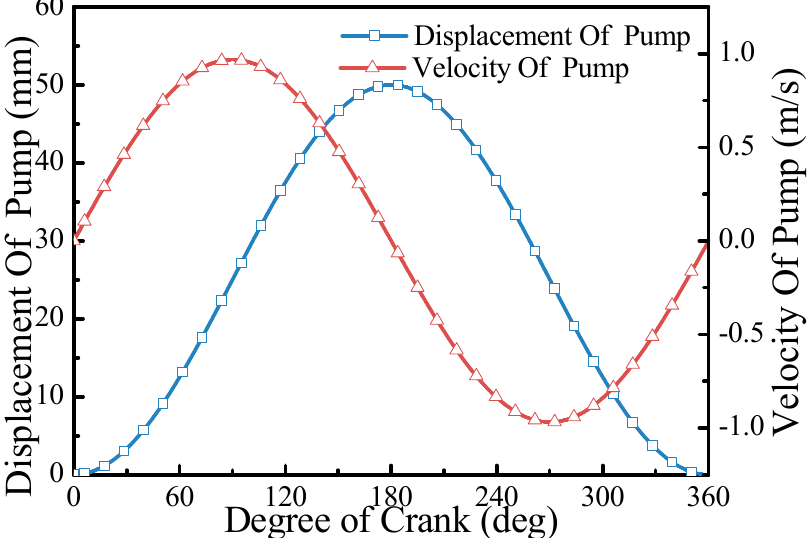
Figure 8. Piston displacement and velocity curve.